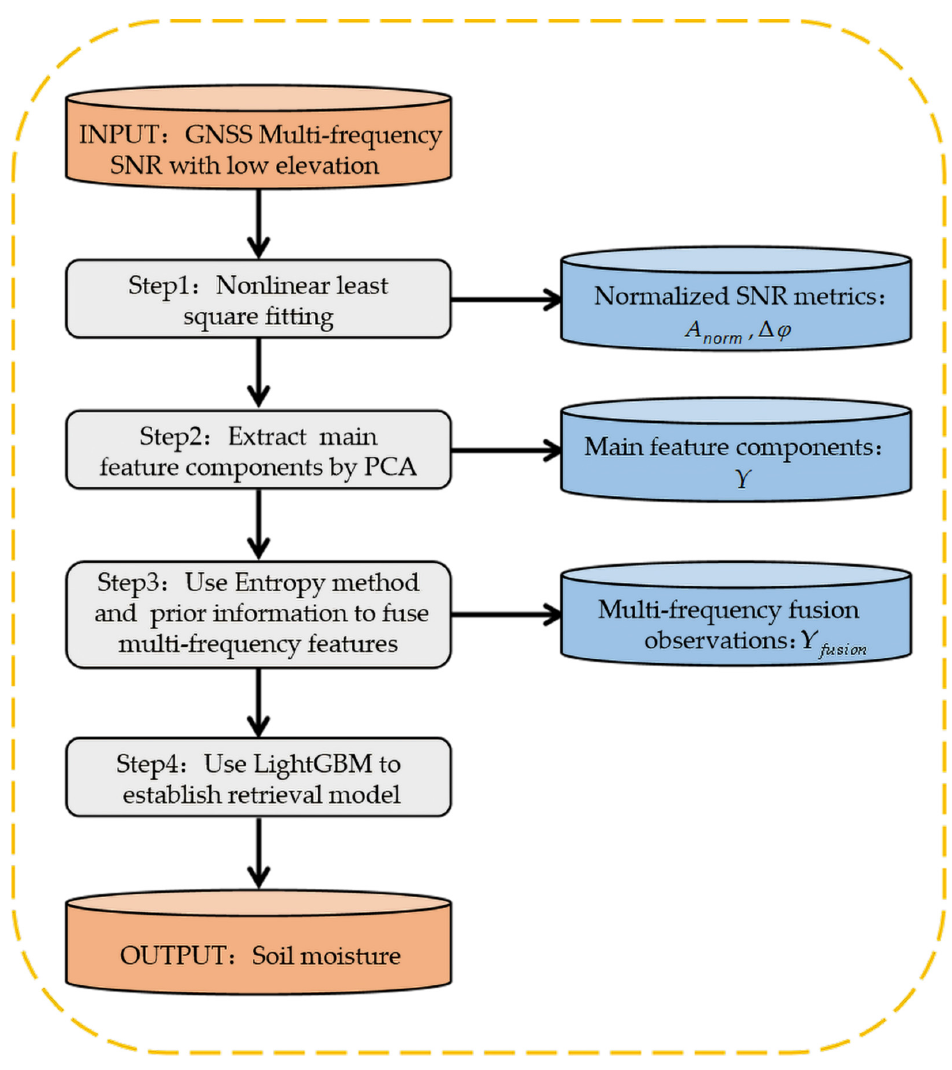
Figure 2. The flow chart of algorithm retrieval process.